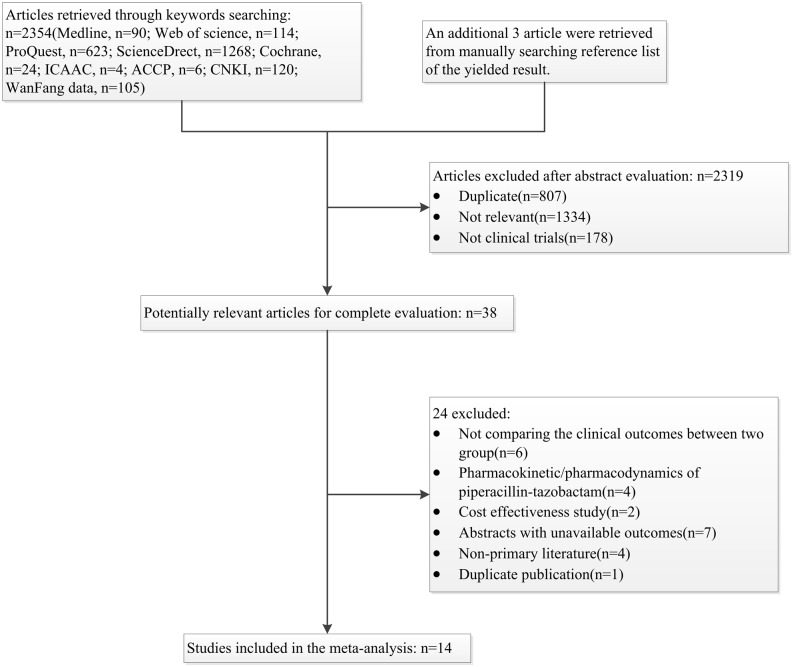
Flow chart depicting the selection process of studies included in the meta-analysis.